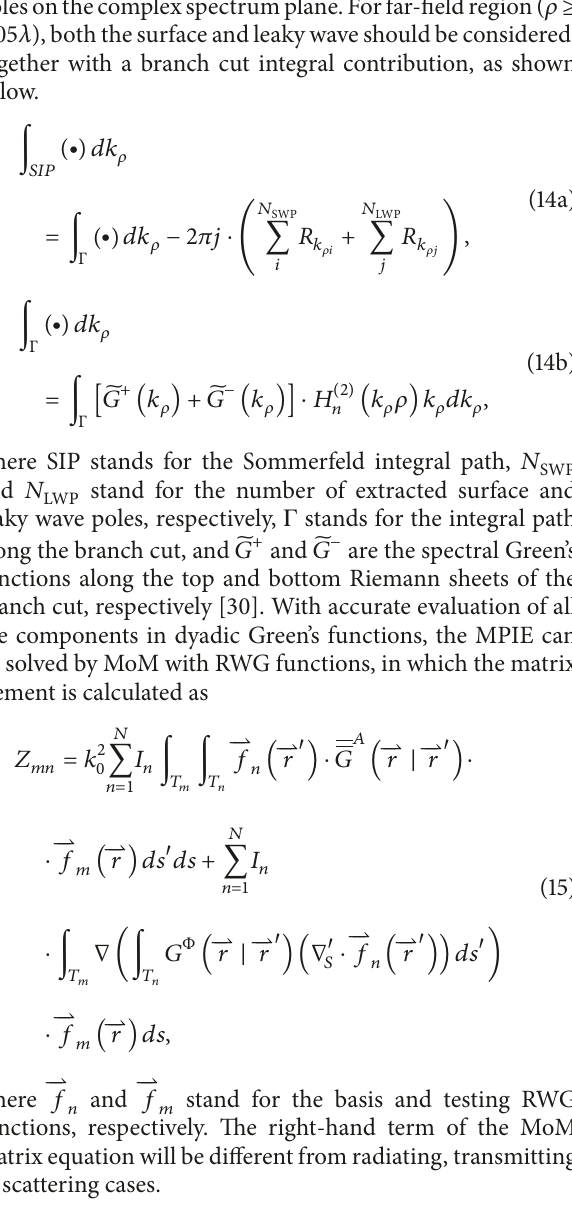
Table 2: Configurations of GPU/CPU platform of numerical exam-